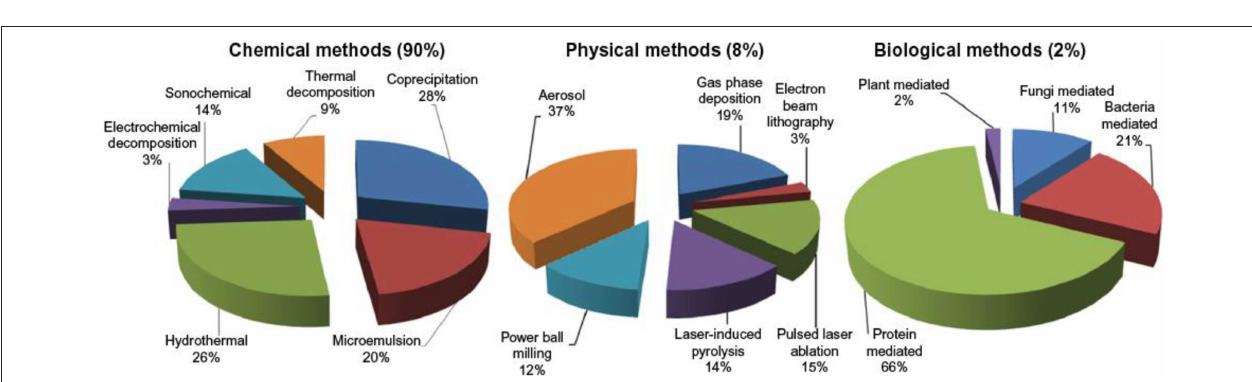
FIGURE 2 | Stabilization of iron oxide nanoparticles; (A) polymer end bearing functional group (B) polymer-grafted (C) di-block copolymer with grafting groups (D) wrapping conformation of the polymer (E) coatings with opposite charges (F) amphiphilic polymers [adapted and modified from Barrow et al. (2015) and Habibi et al. (2017)].